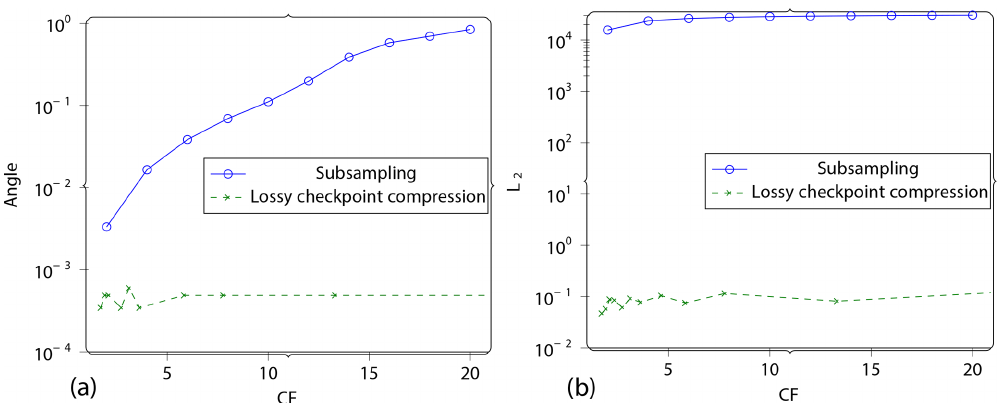
Figure 19. Subsampling. We set up an experiment with subsampling as a baseline for comparison. Subsampling is when the gradient computation is carried at a lower time step than the simulation itself. This requires less data to be carried over from the forward to the reverse computation at the cost of solution accuracy, and thus it is comparable to lossy checkpoint compression. This plot shows the angle between the lossy gradient and the reference gradient vs. the compression factor CF (a) and L 2 norm of gradient error vs. the compression factor CF (b) for this experiment. Compare this to the errors in Fig. 11 that apply for lossy checkpoint